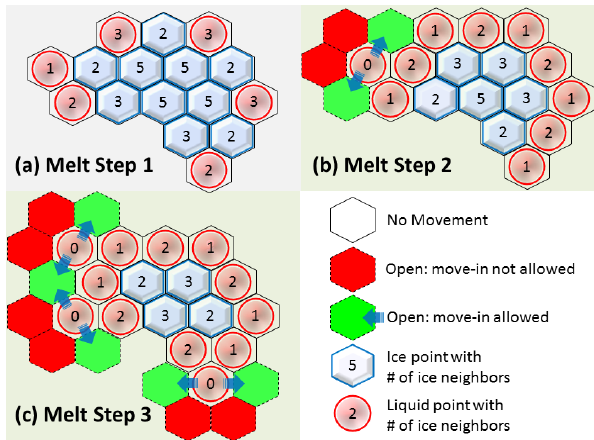
Figure 2. A simplified diagram depicting the steps in the SPMM. At each step, ice (blue) points are converted to liquid (red) follow- ing nearest-neighbor rules (see text). Numbers depict the number of nearest ice neighbors. Panel (a) indicates the first iteration of the melting algorithm; (b) shows the second iteration and the allowable move conditions; and (c) shows the third iteration, where more ice has melted and three points are now free to move into the green